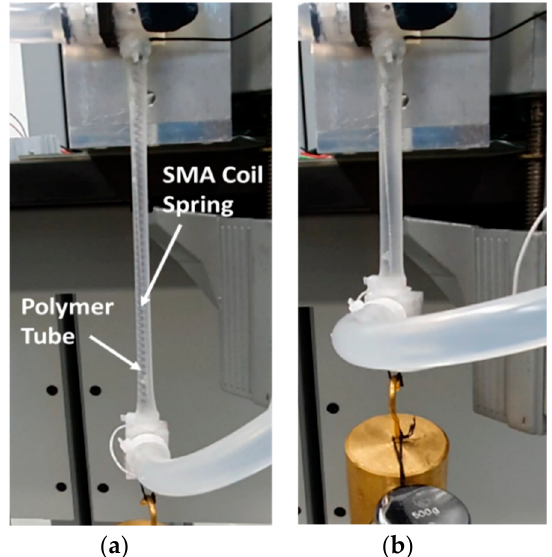
Figure 5. Fabricated SMA-based actuator. ( a ) Extended state, ( b ) Contracted state .